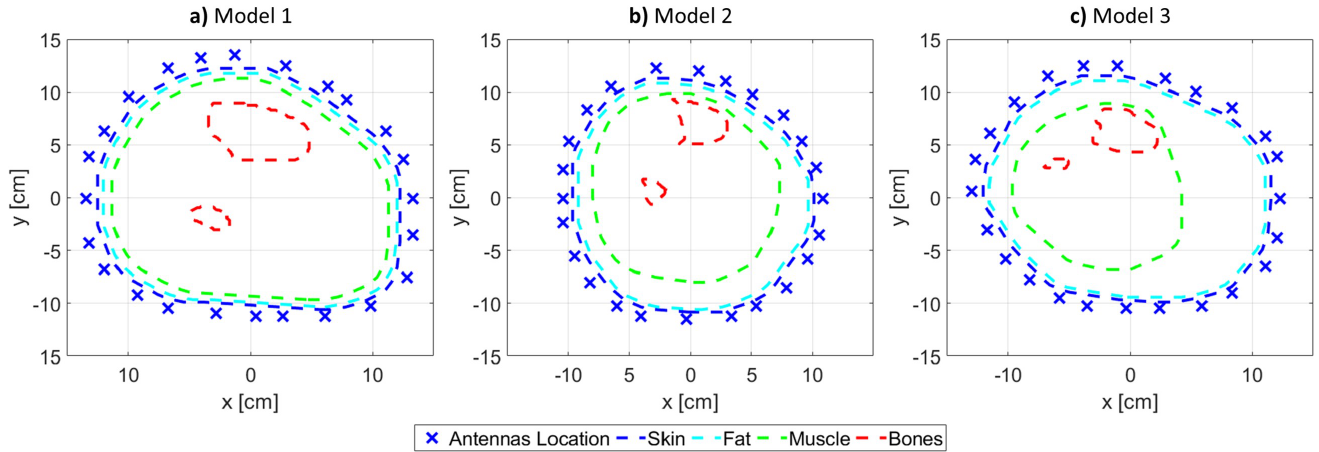
Figure 3. The problem configuration for each model, which includes various tissue boundaries alongside the location of the antennas: ( a ) Model 1, ( b ) Model 2, and ( c ) Model